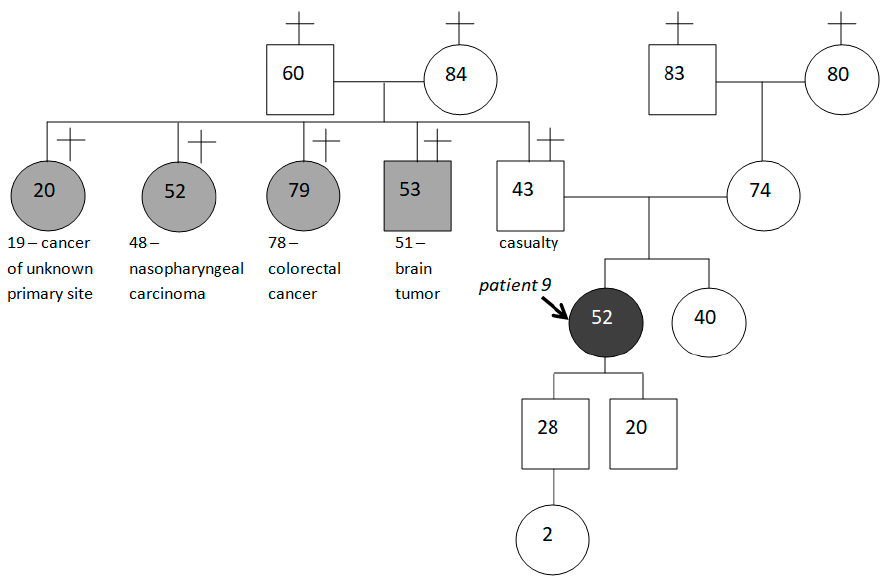
Figure 6. Family history of patient 9, not aggravated by tumors of HBOC-spectrum.